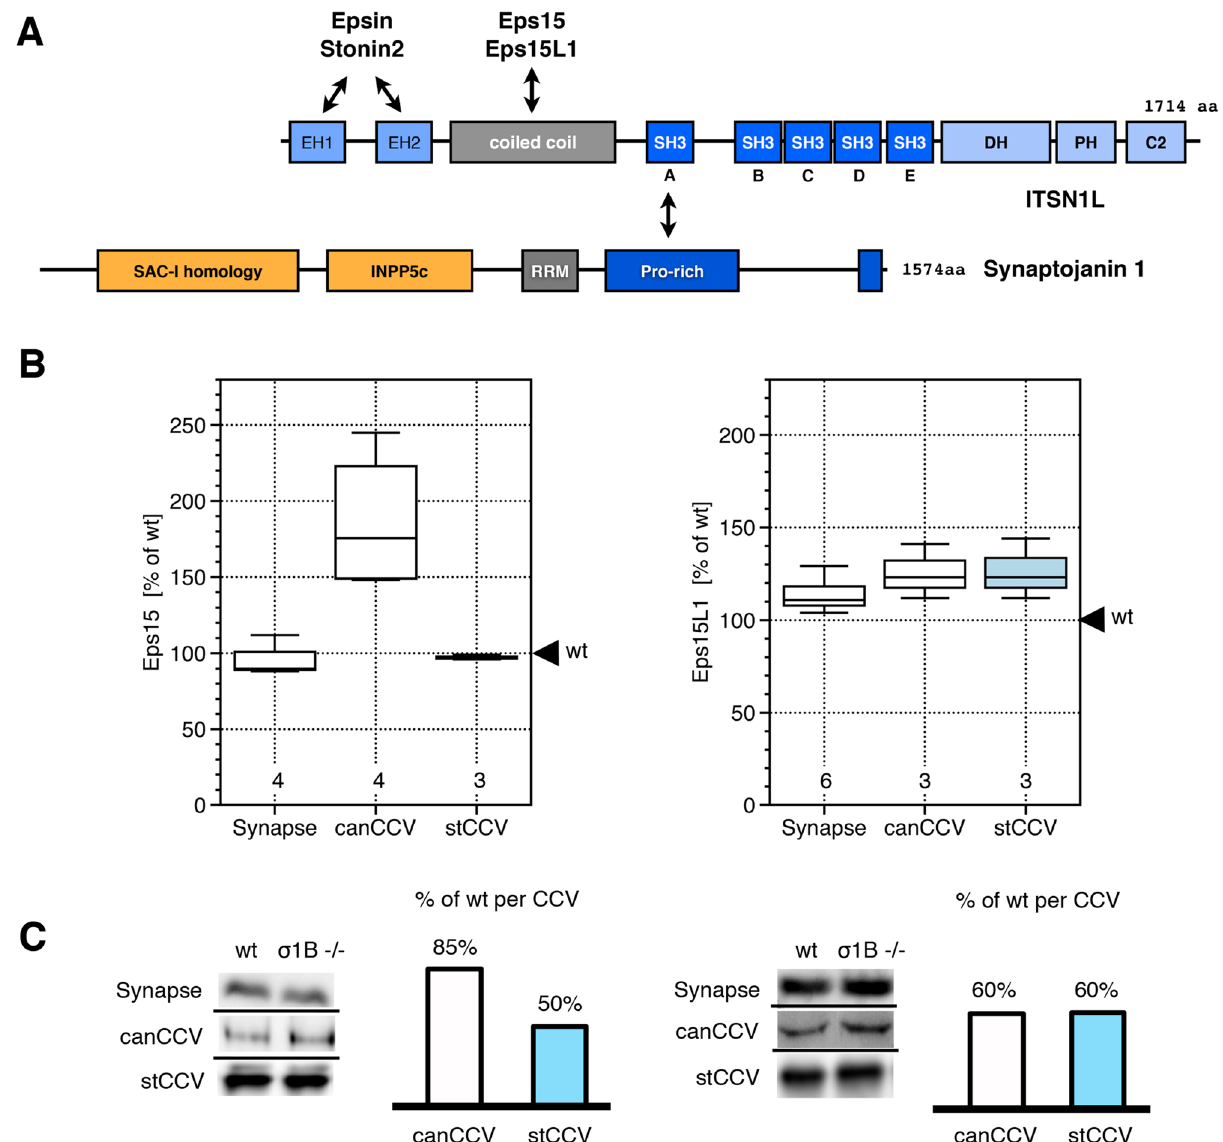
Figure 6. ( A ) ITSN1 domains bound by Eps15 and Eps15L1. ( B ) Alterations in Eps15 and Eps15L1 levels in brain synapses and synaptic CCV of AP-1/σ1B ko mice. Changes are expressed relative to wt brain subfraction levels, defined as 100%. Numbers indicate the repeats of independent biological wt-ko pairs. ( C ) Representative western-blot experiments used for the box-blot diagram (see “Materials and methods” section for